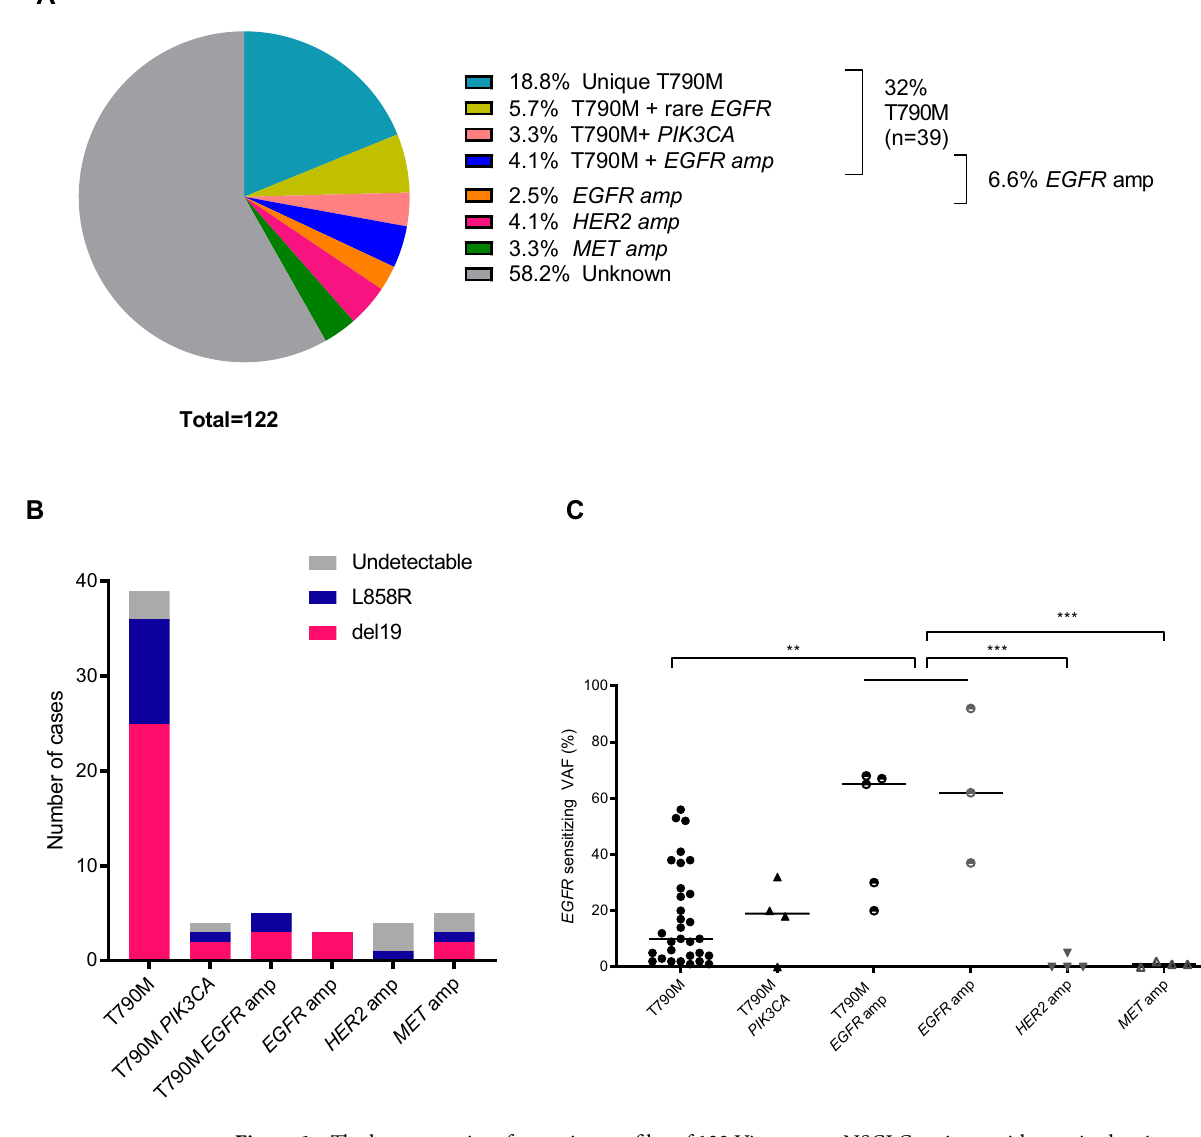
Figure 1. The heterogeneity of mutation profiles of 122 Vietnamese NSCLC patients with acquired resistance to first and second generation EGFR TKI. ( A ) Distribution of TKI resistance associated mutations of 122 Vietnamese NSCLC. ( B ) Frequencies of EGFR sensitizing mutations (del19, L858R, or rare EGFR mutations) in different resistance mutation profiles. ( C ) Variant allele frequency (VAF, %) of EGFR sensitizing mutations in different resistance mutation profiles. Data are presented as median VAF, each data point represents one patient. **p < 0.01; ***p < 0.001 (one-way ANOVA, Kruskal–Wallis